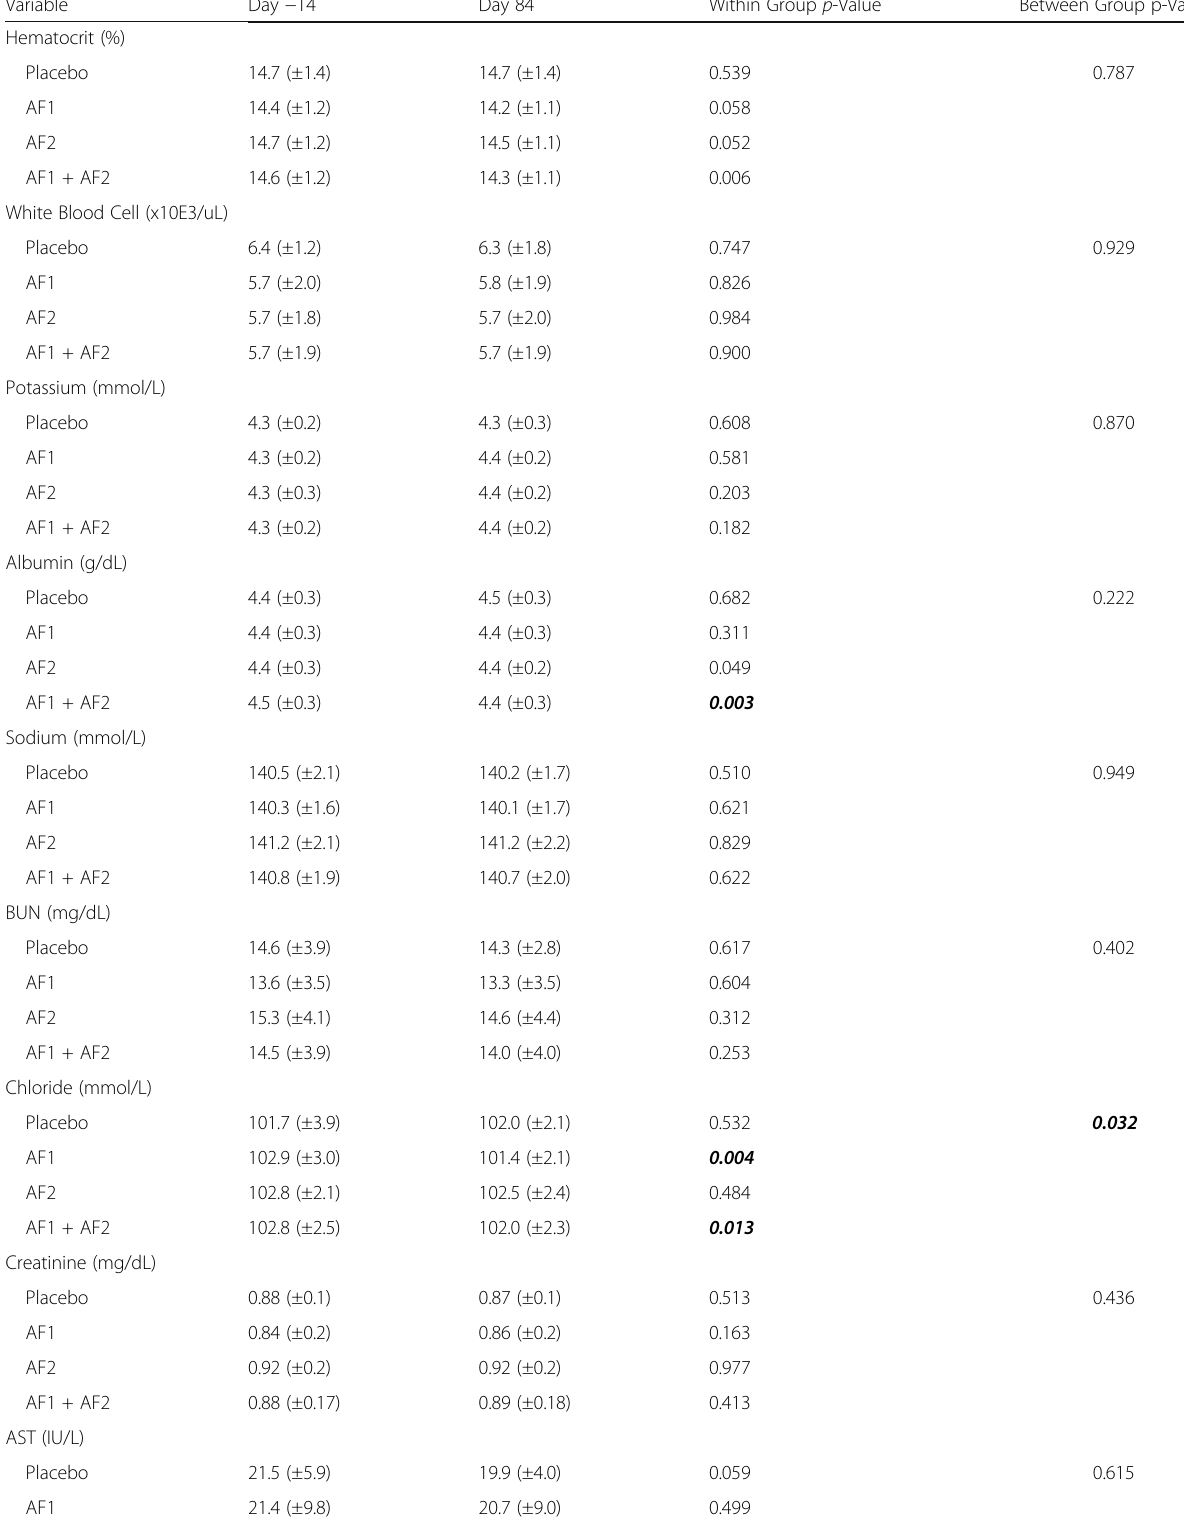
Table 10 Changes in metabolic measures from day − 14 to day